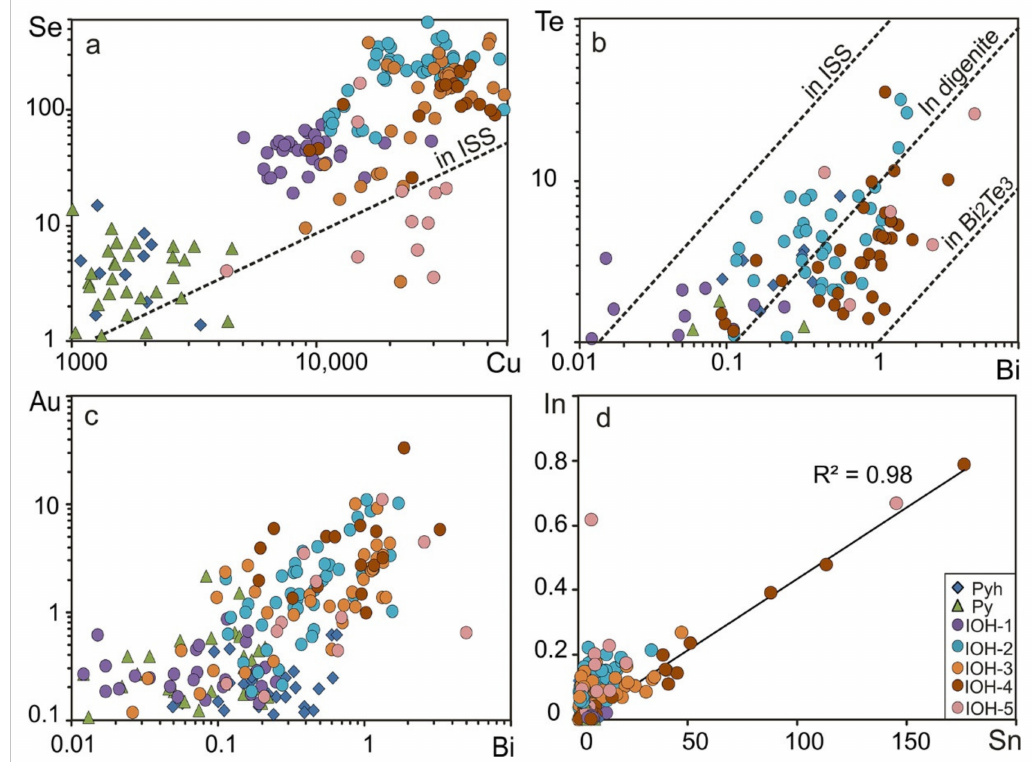
Figure 5. Bivariate plots of: ( a ) Cu vs. Se; ( b ) Bi vs. Te; ( c ) Bi vs. Au and ( d ) Sn vs. In for